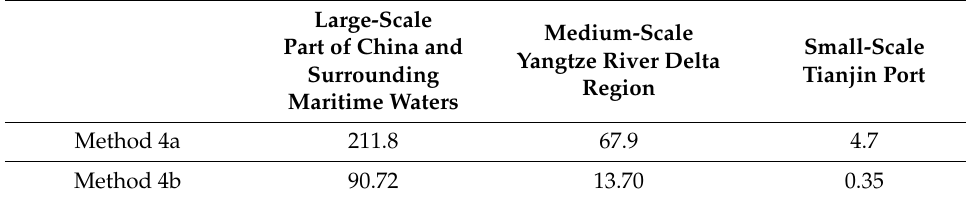
Table 5. Computed results of SO 2 emissions by vessels in Method 4. Unit: 10 4 t.